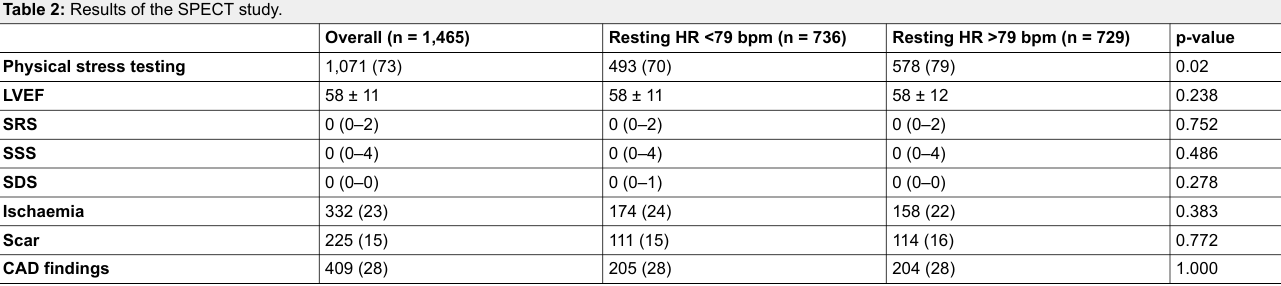
Table 2: Results of the SPECT study.